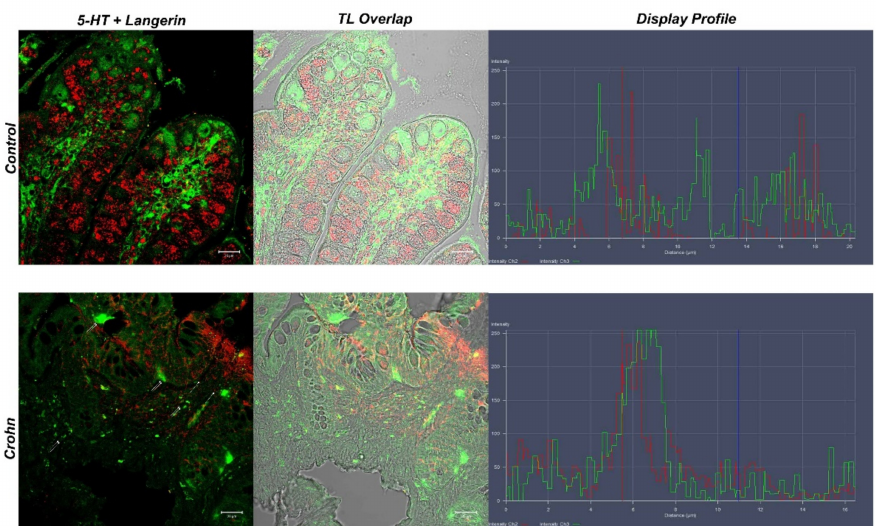
Figure 5. Human intestine. 5-HT/Langerin DC/207 colocalization, 20 × , scale bar 20 nm. The merged photomicrograph indicates the double localization of two antibodies in DCs. In the healthy intestine, 5-HT and Langerin showed overlap, which was more evident in CD samples. Stromal cells are highlighted with arrows. The graph represents the “display profile” function of the laser scanning microscope to show the intensity profile of detected